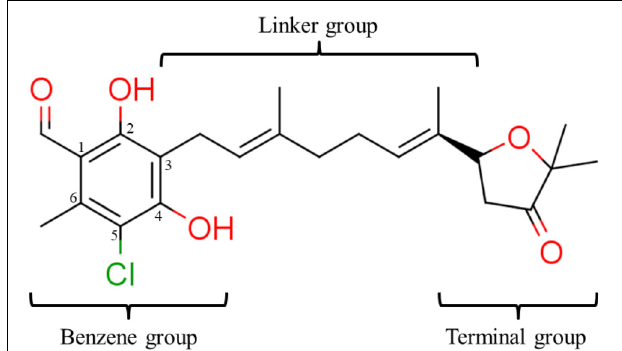
FIGURE 1 | Structure of ascofuranone (AF or 1 ). The benzene, linker and terminal groups are indicated. Oxygen and chlorine atoms were colored in red and green, respectively, to facilitate the visualization of compounds in other figures generated by